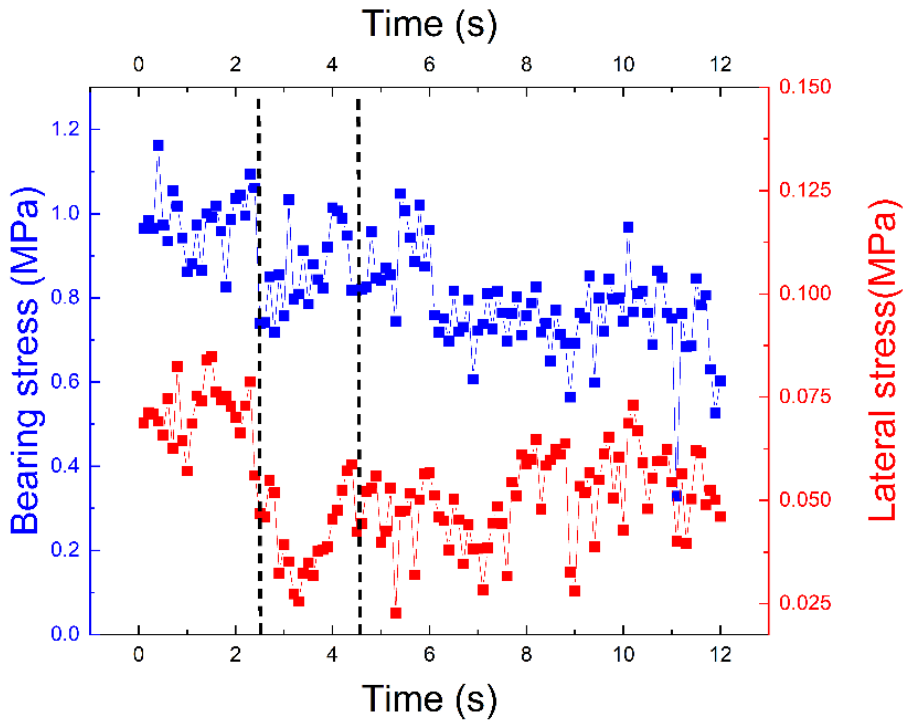
Figure 10. Boundary stress curve.